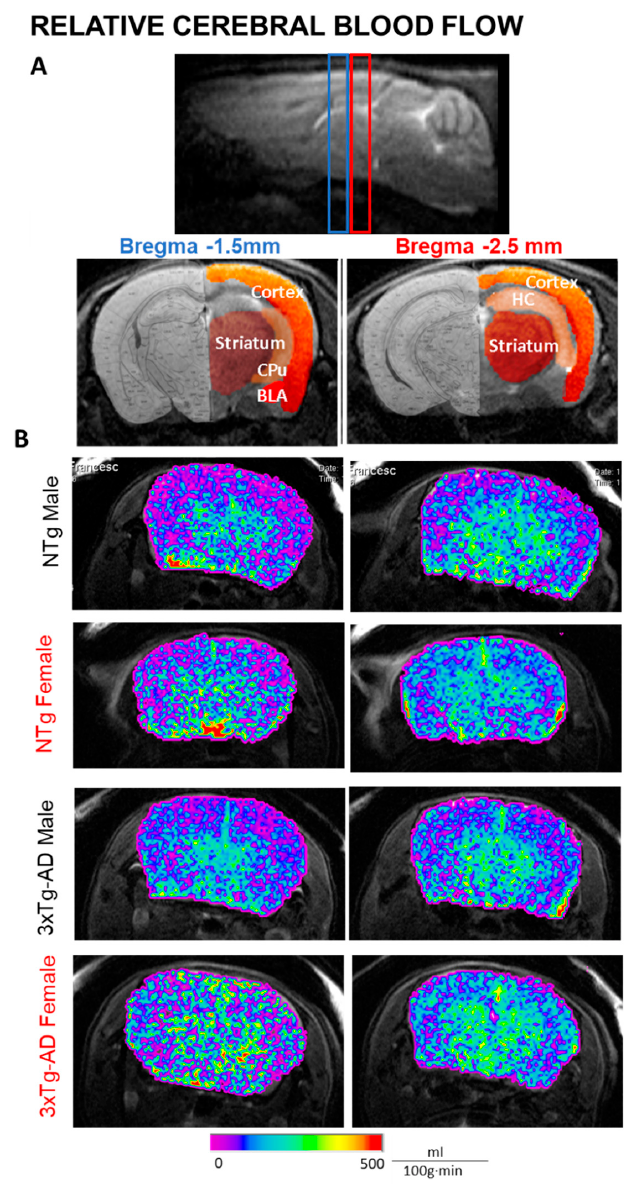
Figure 5. MRI arterial spin labeling (ASL)—relative cerebral blood flow in regions of interest. ( A ) Global cerebral blood flow and five regions of interest were examined in the present study from two different sections (Bregma − 1.5 mm, − 2.5 mm). Cortex; striatum; caudate putamen (CPu); basolateral amygdala (BLA); hippocampus (HC). ( B ) Representative images from rCBF maps superimposed to T2w-image from NTg male, NTg female, 3xTg-AD male, and 3xTg-AD female. For each group, the asymmetries in the rCBF of the left and right hemispheres are illustrated in Figure 6 B. In the cortex, rCBF asymmetries were found in females. The asymmetry between left–right hemispheres was also observed in the hippocampus of NTg males and 3xTg females and the striatum of NTg females (paired t -test, p < 0.05).